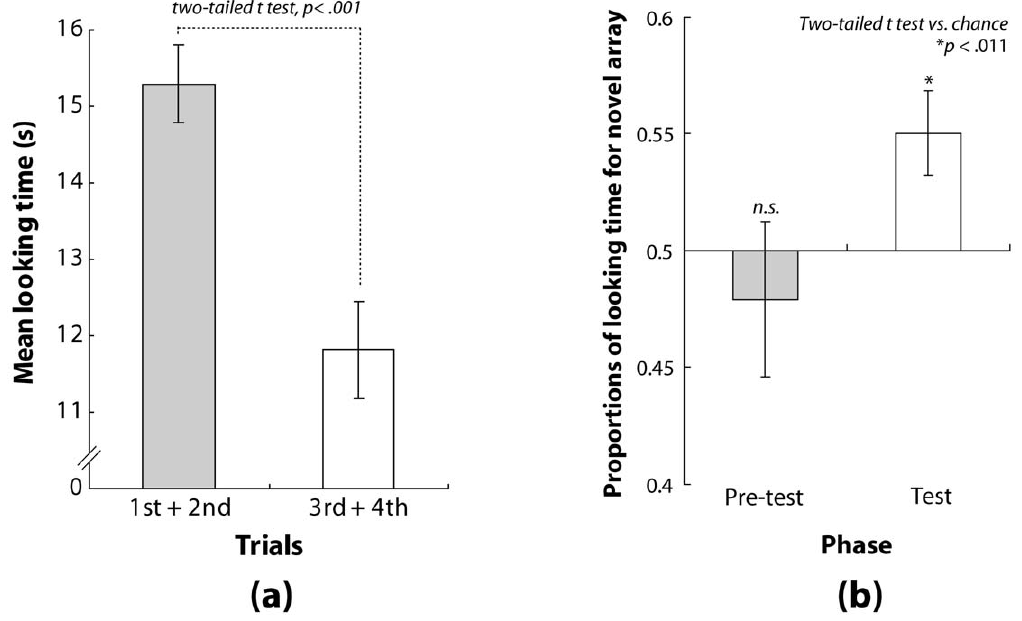
Figure 2. Results of Experiment 1. (a) Mean durations of looking time for the first and second halves of trials in the familiarization phase. Error bars denote standard errors of the means (SEM, N=24). (b) The left and right bars represent mean proportions of looking time for the novel array in the pre-test and test phases, respectively. Error bars denote SEM (N=24).